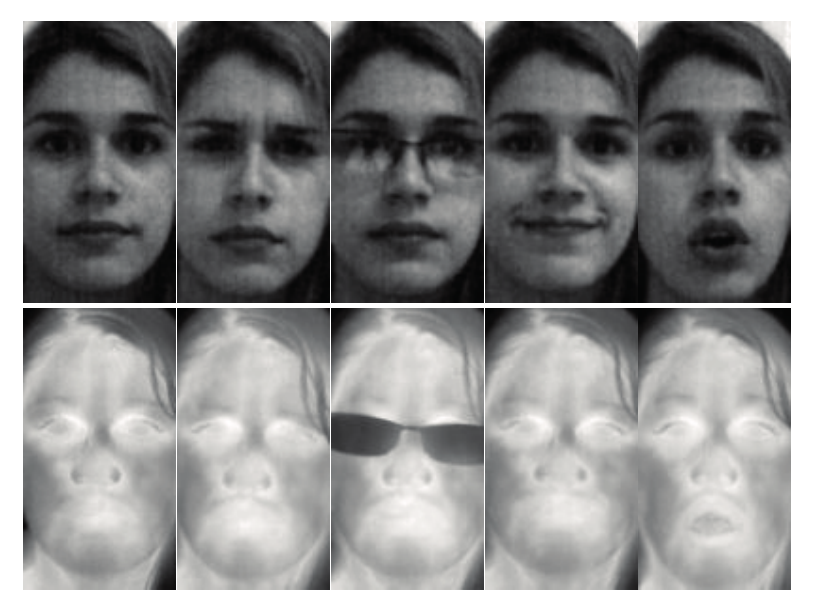
Figure 4. PUCV-VTF database